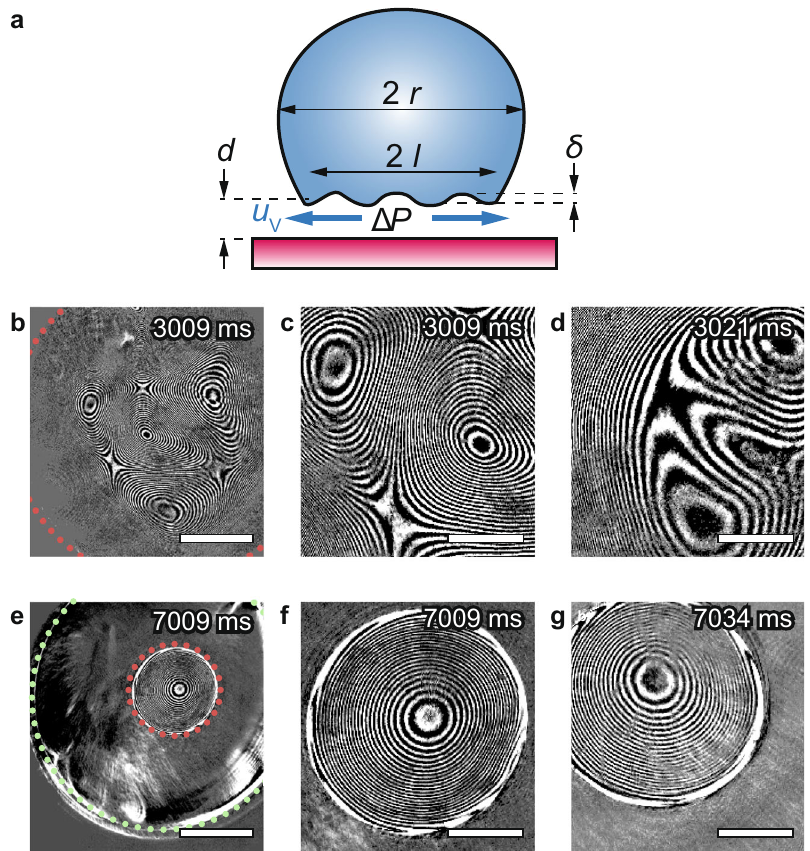
Fig. 3 Leidenfrost trampolining mechanism. a Sketch of a Leidenfrost droplet of instantaneous radius, r , vapor pocket radius, l , and average vapor cushion thickness, d , hovering above a hot surface due to an average overpressure under the droplet, Δ P . The vapor drains under the droplet (illustrated by blue arrows) with a vapor velocity, u v , and causes ripples of amplitude, δ . Bottom-view interferometric images of relatively ( b – d ) large (not trampolining, Bond number Bo → 1) and ( e – g ) intermediate-sized (trampolining; Bo = 0.13; r = 0.9 mm, green dotted line) Leidenfrost droplets on a heated sapphire plate ( b – d : T S = 280 °C; e – g : T S = 250°C). The vapor pocket radii, l , in b ( l = 1.1 mm) and e ( l = 0.25 mm) are shown by a red dashed line. c Magni fi ed image of b showing the interference patterns resulting from the complex shape of the large vapor pocket and d its shape 12 ms later, revealing its oscillatory behavior despite the fact that it is not trampolining. f Magni fi ed image of e revealing the symmetric shape of the small, dome-shaped vapor pocket and g its shape 25 ms later revealing its oscillatory behavior while remaining relatively axisymmetric. Time-zero: b – d , the start of droplet observation; e – g , the moment the droplet is placed on the heated surface. Supplementary material: b – d , Supplementary Fig. 8 and Movie 4; e – g Supplementary Fig. 9 and Movie 5. Scale bars: b and e 0.5 mm; c , d , f , and g : 0.2